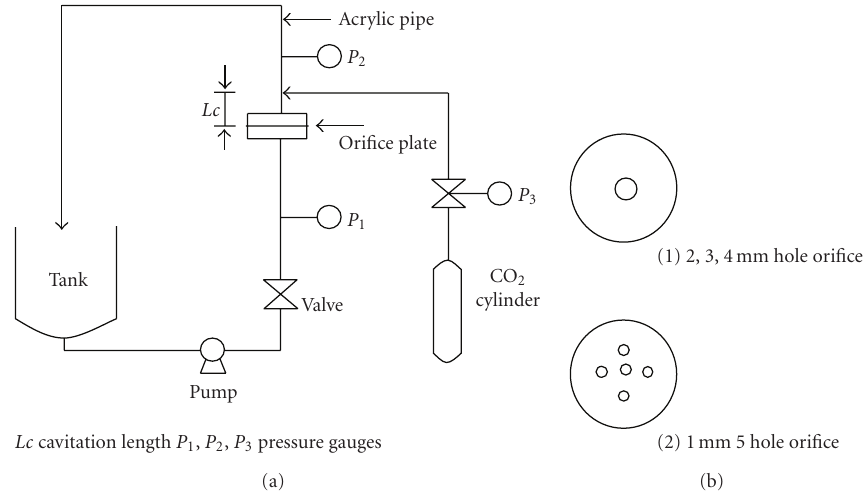
Figure 1: (a) Hydrodynamic cavitation setup for nano-CaCO 3 production. (b) Orifice Configurations used for